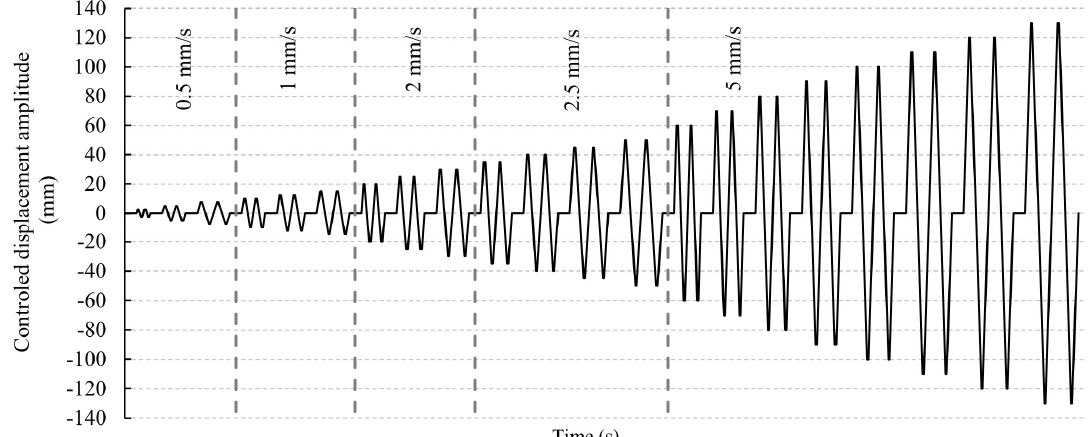
Figure 4. Applied general loading protocol for out-of-plane testing of non-structural wall specimens.